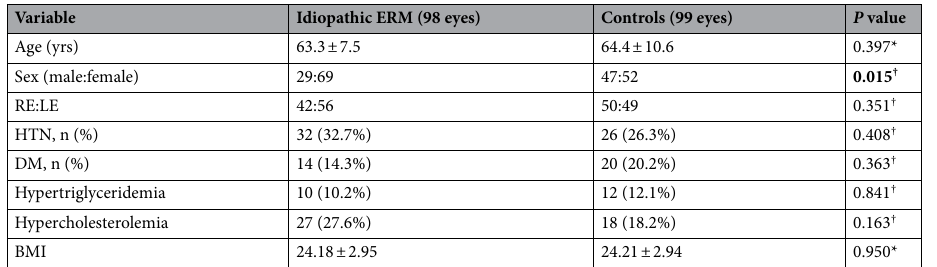
Table 2 shows the comparison of retinal parameters between the idiopathic ERM and control groups. Com- pared with the controls, the idiopathic ERM group had wider arteriolar (163.56 ± 14.15 vs. 158.61 ± 10.42 µm, P = 0.006) and venular calibers (211.64 ± 15.87 vs. 199.79 ± 15.71 µm, P < 0.001). The idiopathic ERM group had smaller total (1.333 ± 0.059 vs. 1.355 ± 0.075, P = 0.022) and arteriolar fractal dimensions (1.146 ± 0.072 vs. 1.181 ± 0.092, P = 0.003) than the control group. Venular fractal dimensions were not different between the groups ( P = 0.638). Furthermore, the idiopathic ERM group had more tortuous venules (0.593 ± 0.137 vs. 0.544 ± 0.119